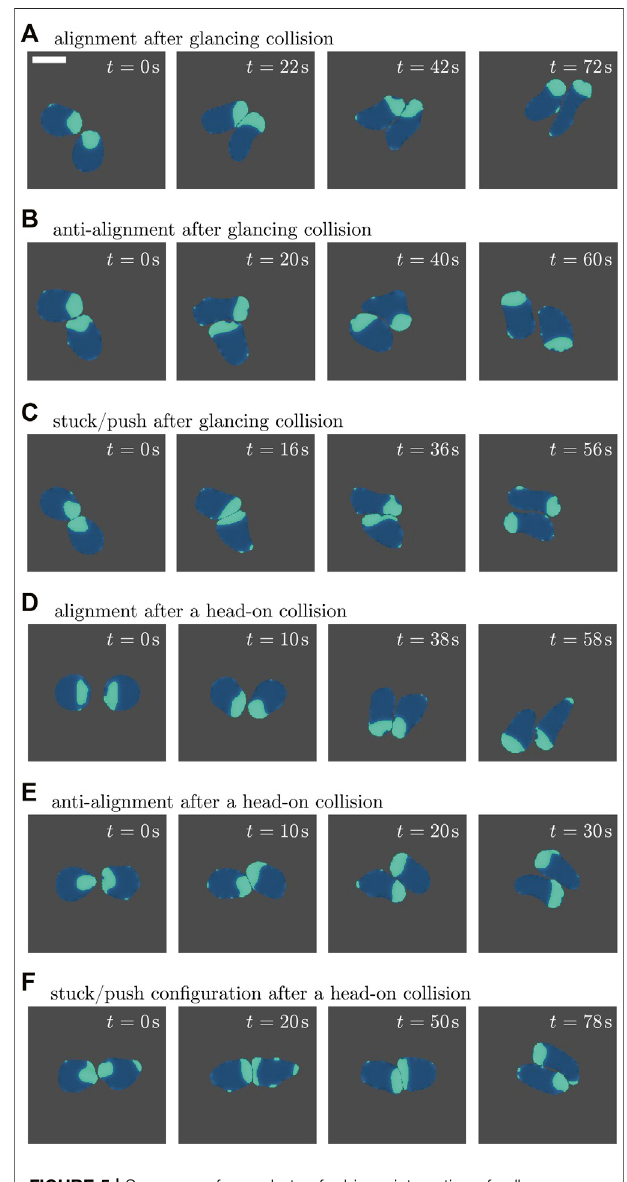
FIGURE 5 | Sequence of snapshots of a binary interaction of cells, representing (A) alignment (Movie SM1), (B) anti-alignment (Movie SM2) and (C) stuck/push (Movie SM3) scenarios for a glancing collision. Panels (D – F) showthealignment(MovieSM4),anti-alignment(MovieSM5)andstuck/ push (Movie SM6) scenarios, respectively, corresponding to head-on collision. Scale bar: 10 μ m .